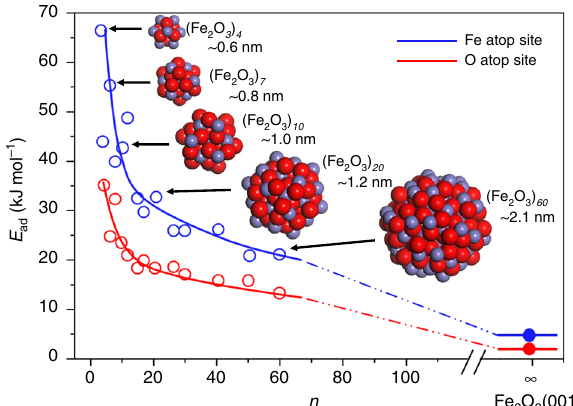
Fig. 4 Calculated energies of CH 4 adsorption. E ad (kJ mol − 1 ), on Fe atop site and O atop site of (Fe 2 O 3 ) n nanoparticles as a function of n . The adsorption trends are shown by the blue and red lines.